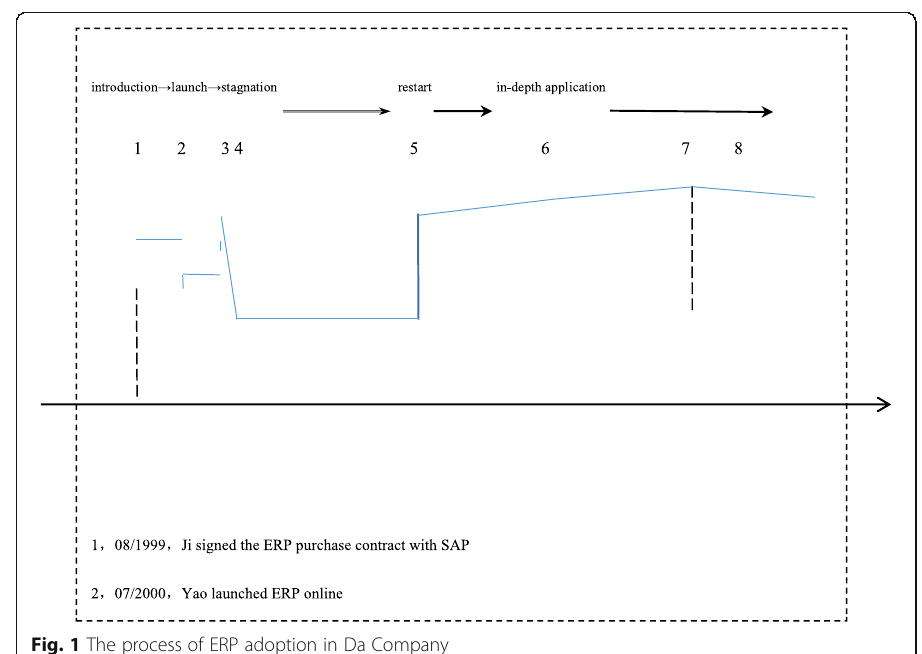
Fig. 1 The process of ERP adoption in Da